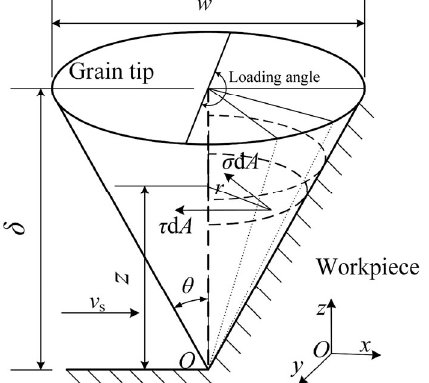
Fig. 4 Grinding force of a grain